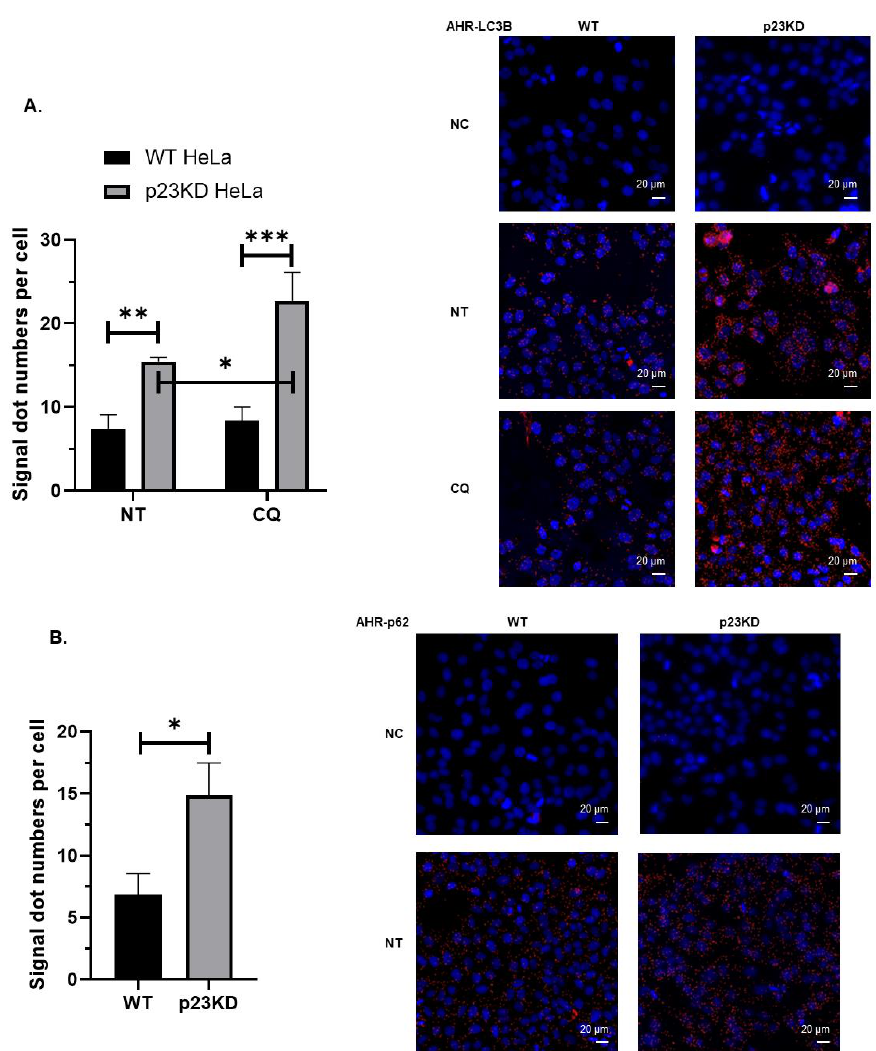
detected in p23 knockdown HeLa cells (Figure 6A). Both cell lines showed minimal levels of K48- an AHR ligand 3MC in the presence of a proteasome inhibitor MG132 showed a more intense K48- ubiquitinated AHR protein (Figure 6B), which exhibited a pattern that was different from the K63- ubiquitination of AHR as shown in Figure 6A. Collectively, these data supported that the basal AHR ( D ) p62 was co-immunoprecipitated by AHR monoclonal antibody A-3x after treatment of 40 µ M protein undergoes K63-ubiquitination (but not K48-ubiquitination) in HeLa cells and this K63- CQ for 6 h in WT HeLa cells. This experiment was repeated once with similar results. For A-B, each Western lane contained 30 µ g of whole-cell lysate or the whole immunoprecipitation content from 1 to selec 2 mg of whole-cell lysate starting material (C and D). Data were normalized by total protein stain.